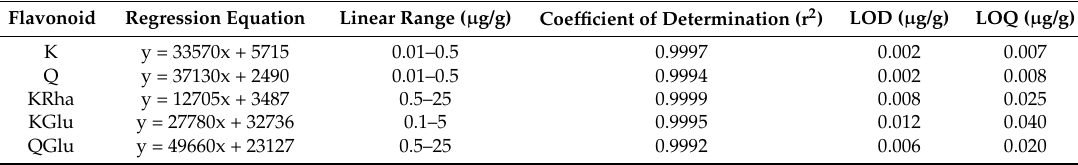
Table 3. Calibration curve equations, linearity ranges, LODs, and LOQs of the standard solutions. Flavonoid Regression Equation Linear Range ( µ